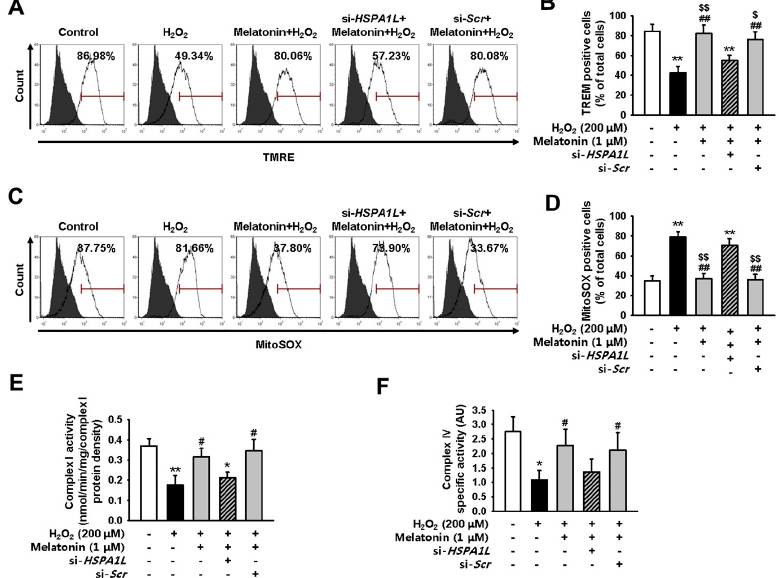
Figure 5. Melatonin enhances mitochondrial function by stabilizing parkin in hMSCs subjected to oxidative stress. ( A ) hMSCs were pre-treated with melatonin (1 μ M, 24 h) and si- HSPA1L , and subjected to oxidative stress. Untreated hMSCs were subjected to oxidative stress only. All groups were assayed using TMRE, and TMRE-positive hMSCs were quantified using FACS. ( B ) Values represent the mean ± SEM. ** p < 0.01 vs. untreated hMSCs, ## p < 0.01 vs. H 2 O 2 -treated hMSCs, $ p < 0.05, and $$ p < 0.01 vs. melatonin-treated hMSCs pretreated with si- HSPA1L . ( C ) hMSCs were pre-treated with melatonin (1 µ M, 24 h) and si- HSPA1L , and subjected to oxidative stress. Untreated hMSCs were subjected to oxidative stress only. All groups were assayed using MitoSOX, and MitoSOX-positive hMSCs were quantified using FACS. ( D ) Values represent the mean ± SEM. ** p < 0.01 vs. untreated hMSCs, ## p < 0.01 vs. H 2 O 2 -treated hMSCs, $$p < 0.01 vs. melatonin-treated hMSCs pretreated with si- HSPA1L . ( E and F ) Activity of complexes I (E) and IV (F) in hMSCs treated with melatonin (1 µ M, 24 h) and si- HSPA1L . Values represent the mean ± SEM. * p < 0.05, and ** p < 0.01 vs. untreated hMSCs; # p < 0.05 vs. H 2 O 2 -treated hMSCs; $ p < 0.05 vs. melatonin-treated hMSCs pretreated with si- HSPA1L